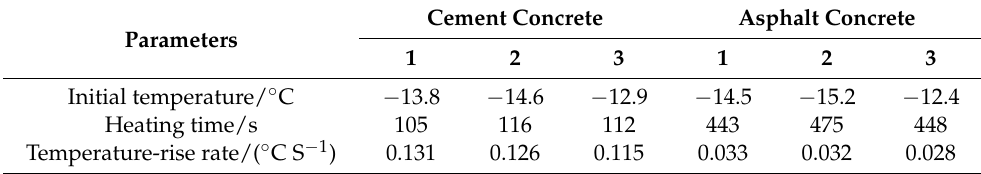
Table 8. Deicing efficiency of concrete with different pavement materials at 2.45 GHz frequency.